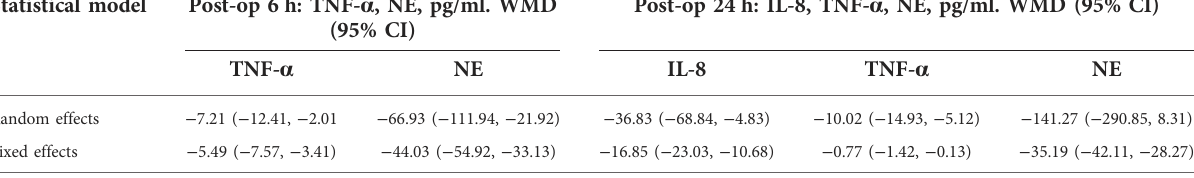
TABLE 4 In fl uence of statistical model on TXA ef fi cacy of in fl ammatory biomarkers IL-8, TNF- α , and NE. Statistical